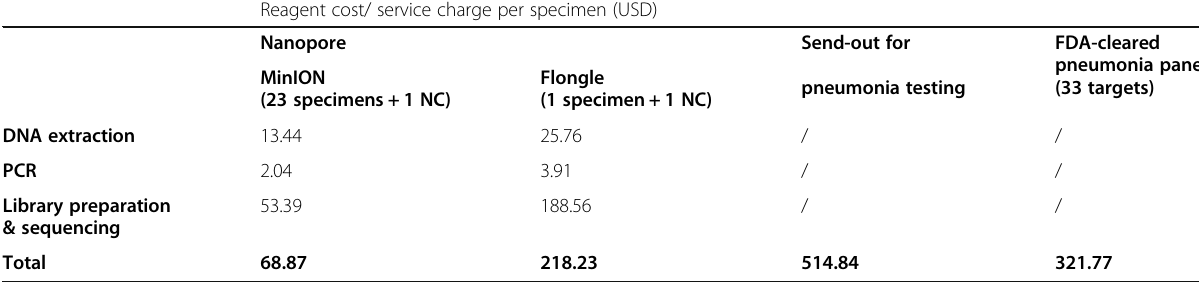
Table 5 Estimated reagent cost of Nanopore workflow (24-plex for MinION; 1 specimen for